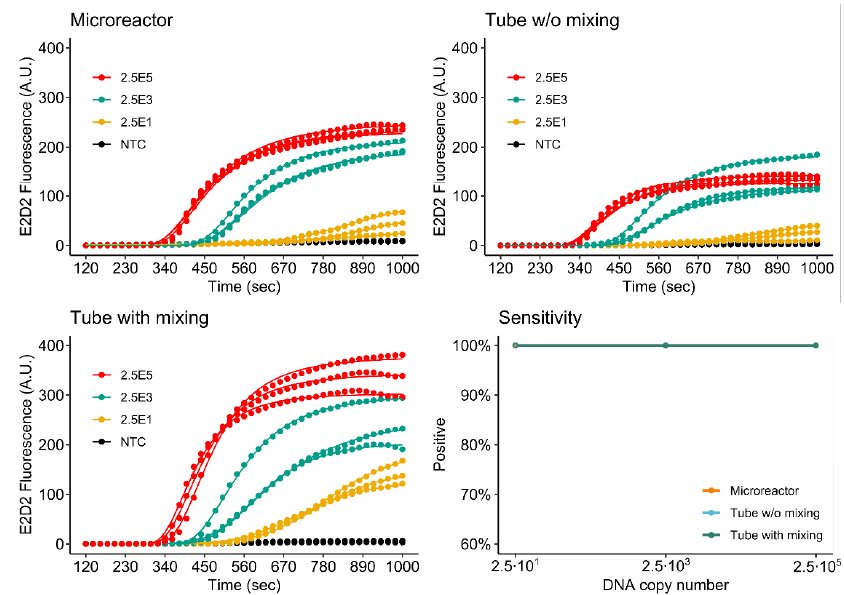
Figure 10. Detection of bla NDM-1 by singleplex rtRPA.